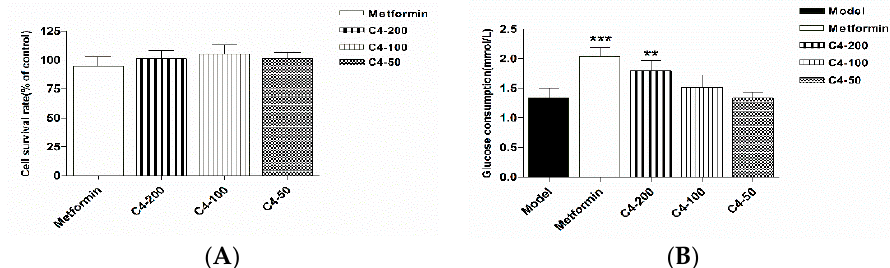
Figure 6. Effect of compound 4 (C4) on cell viability ( A ) and glucose consumption ( B ) in the HepG2 cell. Data are shown as the mean ± SD ( n = 6). ** p < 0.01, *** p < 0.001 versus model. Table 1. NMR spectroscopic data of 1 and 2 in (DMSO- d 6 ) ( δ in ppm and J in Hz) a b.